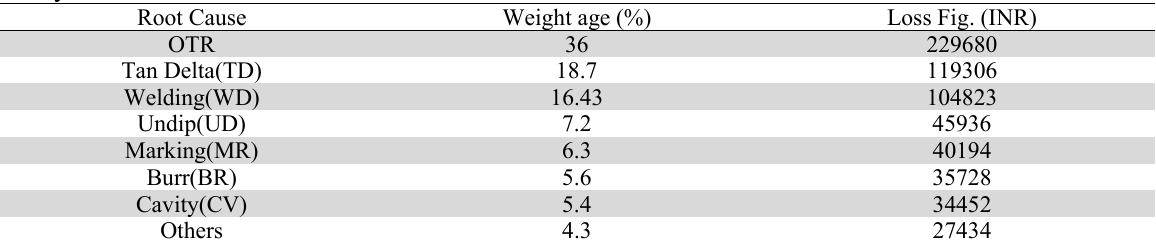
Analysis of root cause Root